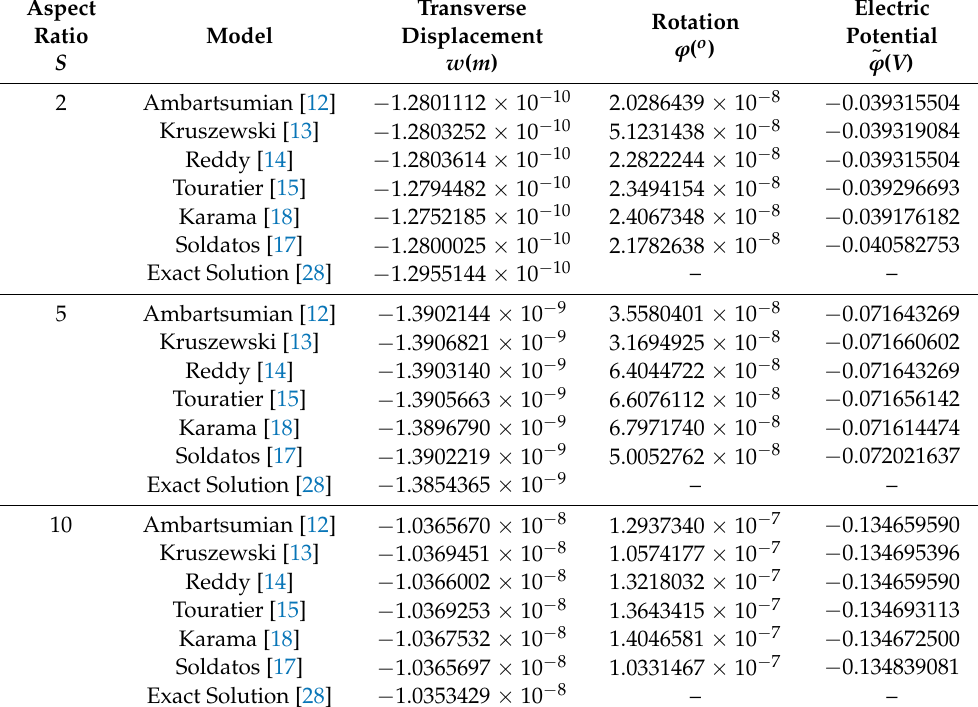
Table 3. Comparison of transverse displacement w at the center of the beam ( x = L /2 ) , rotation ϕ at the end of the beam ( x = 0 ) and electric potential (cid:101) ϕ at the center of the beam ( x = L /2, z = 0 ) for linear high order shear deformation theories of piezoelectric beams with aspect ratios S = 2, 5, 10,